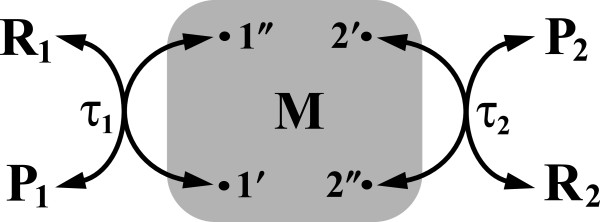
Chemo-chemical molecular machine. A scheme of two coupled free energy-donating R1 ⇔ P1 and free energy-accepting R2 ⇔ P2 enzymatic reactions involving the intramolecular conformational dynamics of the enzyme macromolecule. The multitude of conformational transitions within the complex M is represented by the shaded box. Both coupled reactions are assumed to be gated by certain conformational substates distinguished here as the black dots. The transitions between gates are characterized by the external transition times τ1 and τ2.